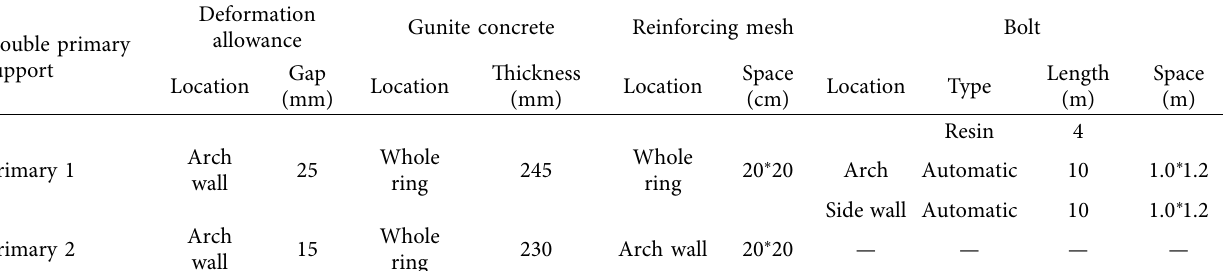
Figure 9: Schematic diagram of double primary support and secondary lining. Table 2: Parameters of double primary support.